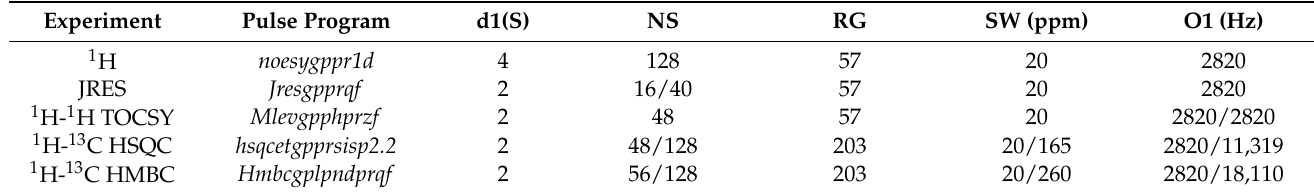
Table 6. Details of the NMR experiment and relative